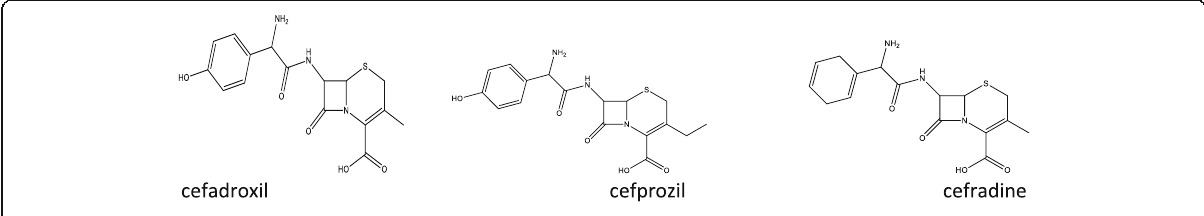
Fig. 1 Chemical structure of the three selected cephalosporins